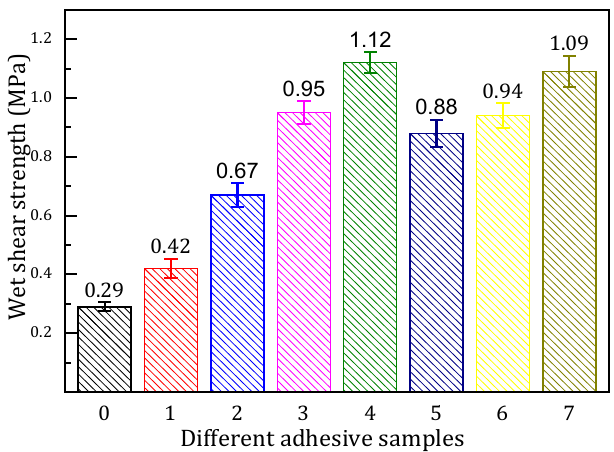
Figure 6. The tensile shear strength of the plywood bonded with the different adhesives: 0 (SM adhesive), 1 (SM/SDS adhesive), 2 (SM/SDS/NGDE-2 adhesive), 3 (SM/SDS/NGDE-4 adhesive), 4 (SM/SDS/NGDE-6 adhesive), 5 (SM/SDS/NGDE-8 adhesive), 6 (SM/PAE adhesive), and 7 (MUF